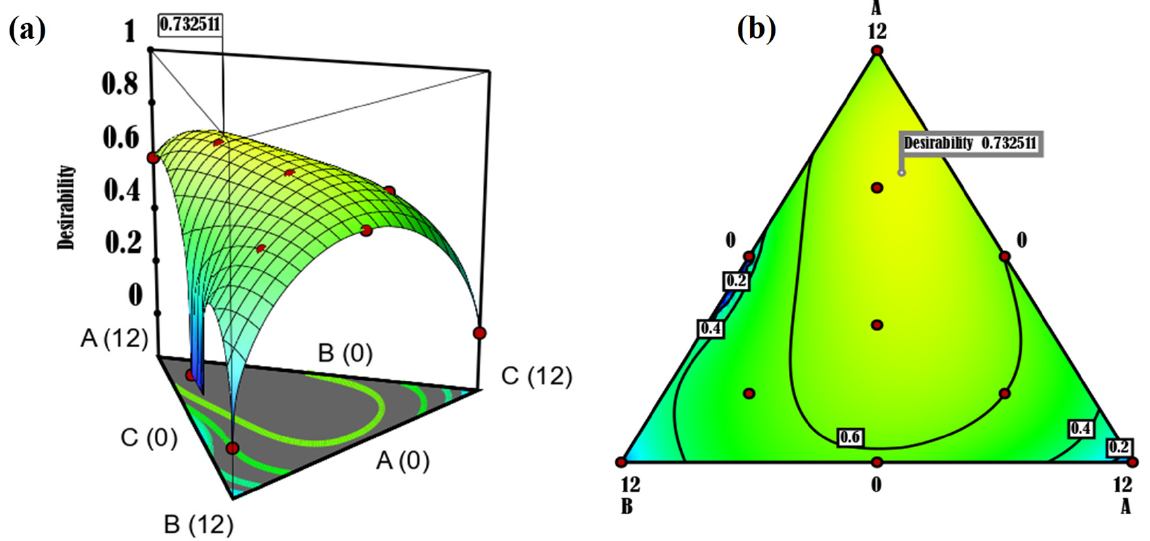
Figure 8. Desirability: ( a ) response surface plot and ( b ) ternary plot.